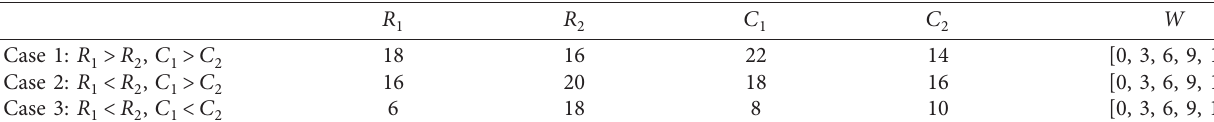
Table 6: Parameter setting of situation